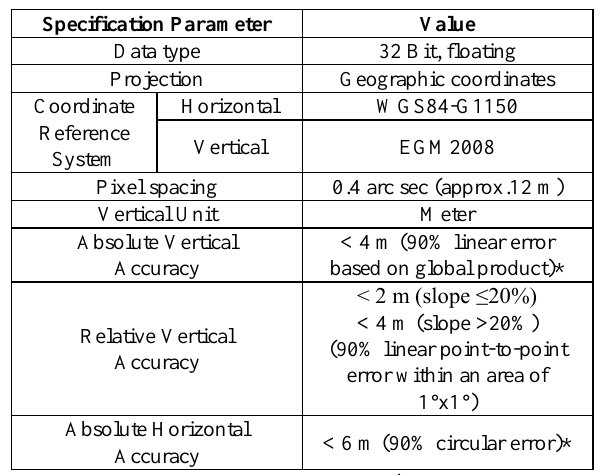
Table 1. WorldDEM Specification and